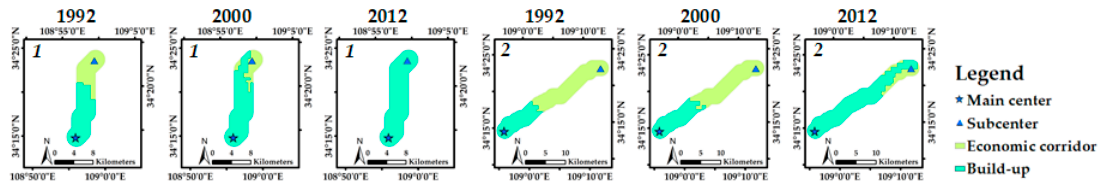
Table 6 . Statistics of the built-up areas within the economic corridor for Wuhan.